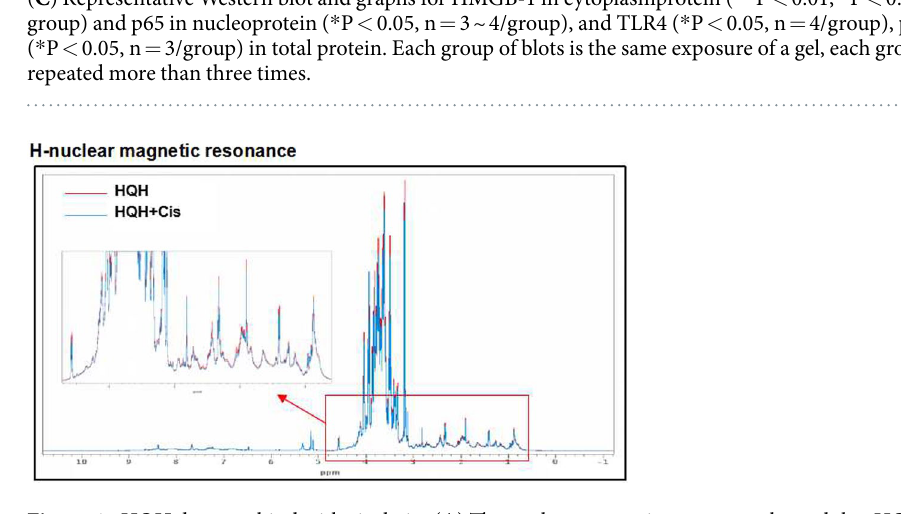
Cisplatin-induced nephrotoxicity involves a complex multifactorial process. First, cisplatin has a direct toxic effect on the renal tubular cells and renal blood vessels, resulting in a decline in renal blood flow and glomerular filtration rate. Second, cisplatin induces renal interstitial inflammation and chronic interstitial fibrosis, leading to